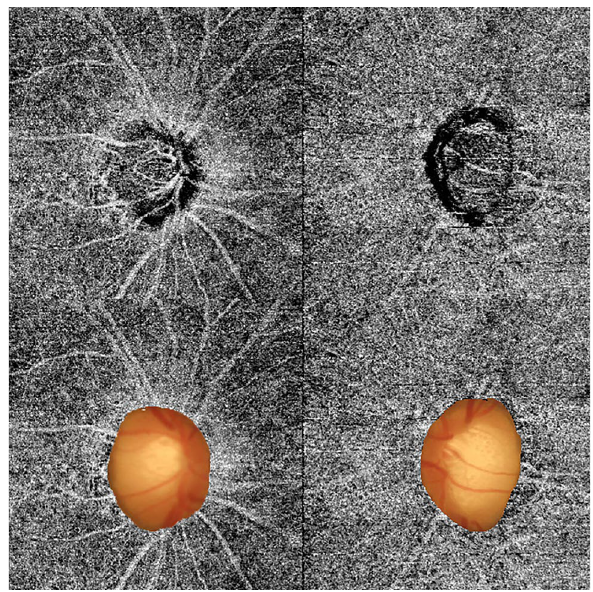
Figure 2. Two representative cases with contrasting features. Left image is low parapapillary choroidal vessel density with high LF/HF ratio (5.41). Right image is high parapapillary choroidal vessel density with low LF/HF ratio (2.18). The vessel density was measured in whole area except for the optic disc